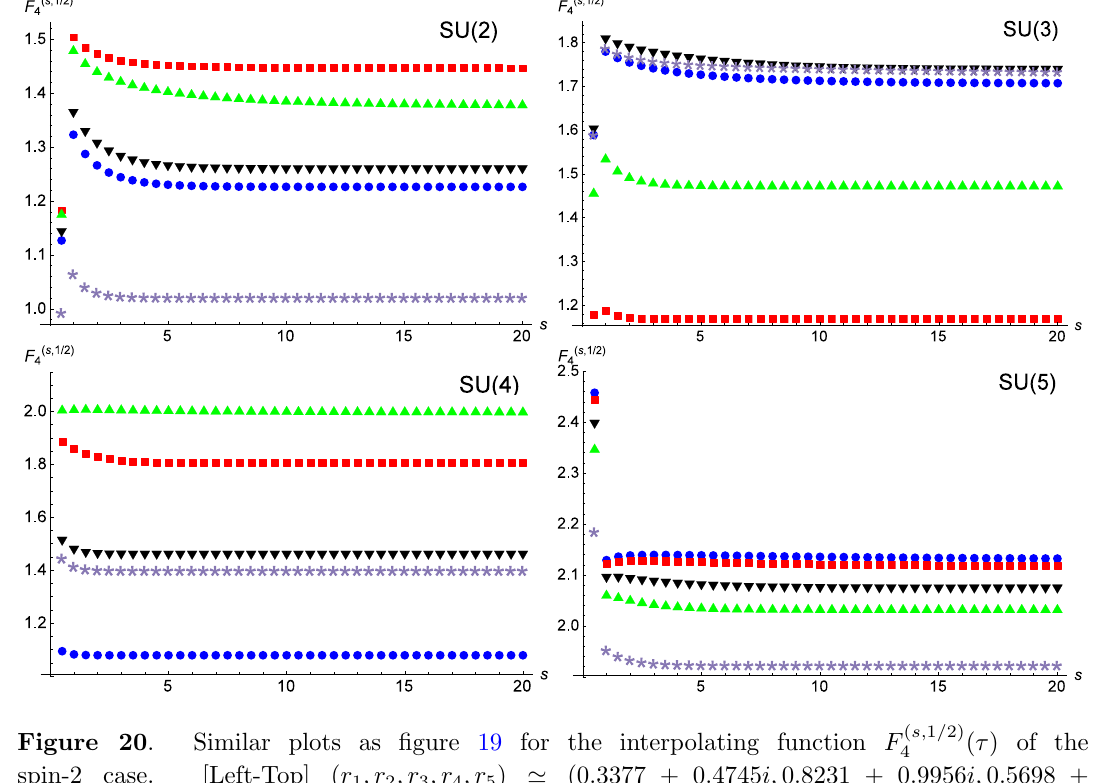
Figure 20 . Similar plots as (cid:12)gure 19 for the interpolating function F ( s; 1 = 2) spin-2